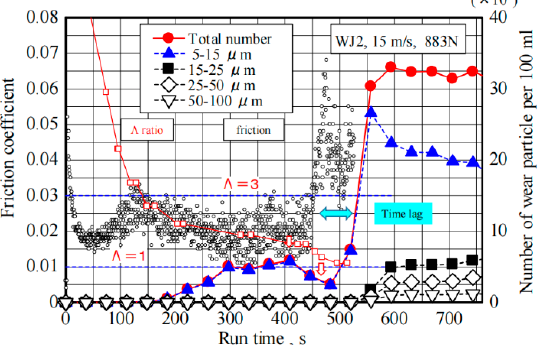
Figure 11. Relationships between the friction coefficient, number of wear particles, and run-time. Reprinted with permission from Ref. [74]. 2016, Japanese Society of